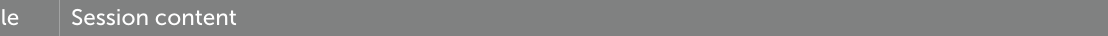
TABLE 1 Transdiagnostic SUD Therapy